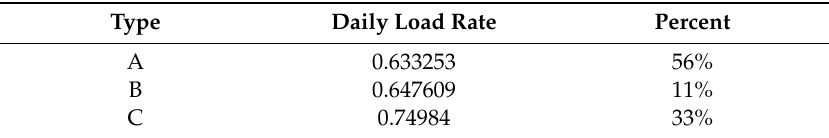
Figure 4. Air conditioning load curve of different classes.